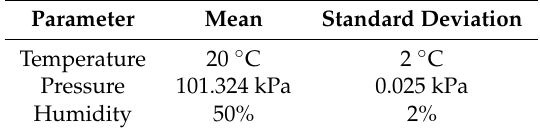
Table 3. Mean and standard deviation of atmospheric parameters for turbulent air.